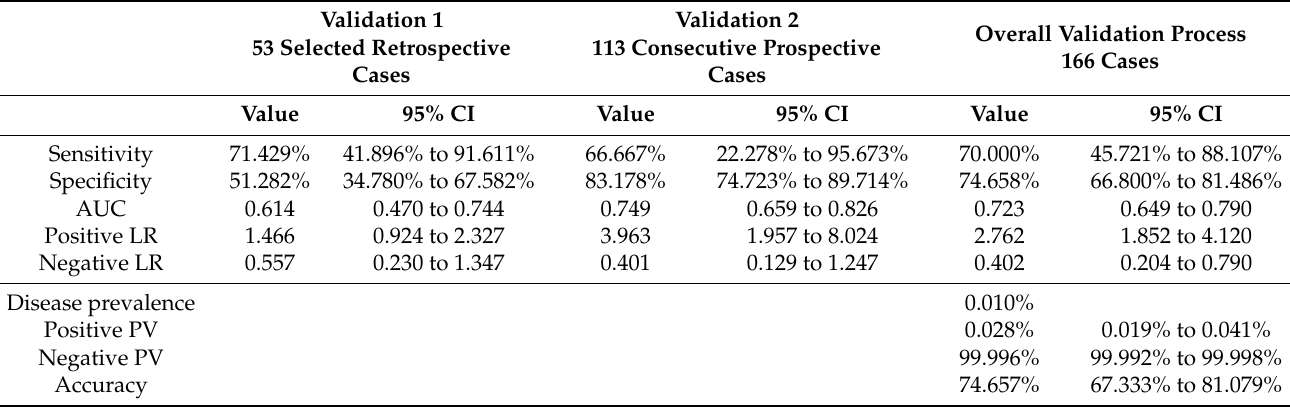
Figure 2. Distribution of DSC results taken from the validation 1 ( A ) and validation 2 ( B ) datasets according to the diagnostic categories. Table 4. Prediction value of DSC test for GC